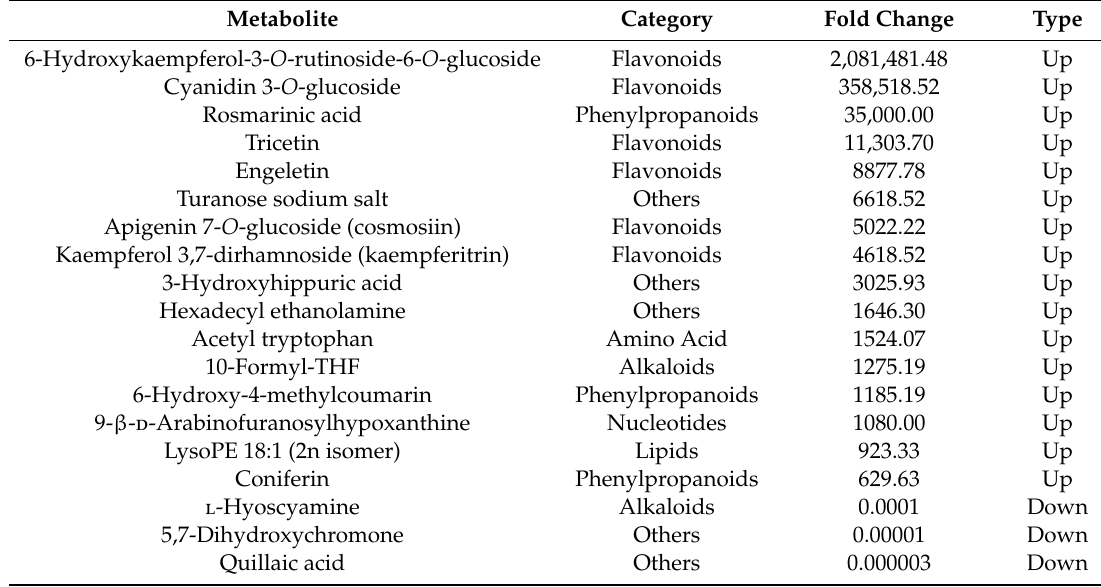
Table 1. Biomarkers for Rhodiola crenulata from di ff erent